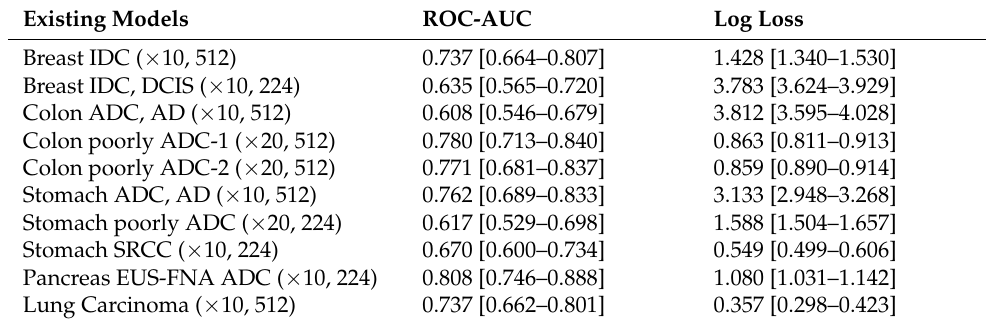
Table 3. ROC-AUC and log loss results for adenocarcinoma classification on transuretheral resection of prostate (TUR-P) test sets (Hospital-A-B) using existing adenocarcinoma classification models. Existing